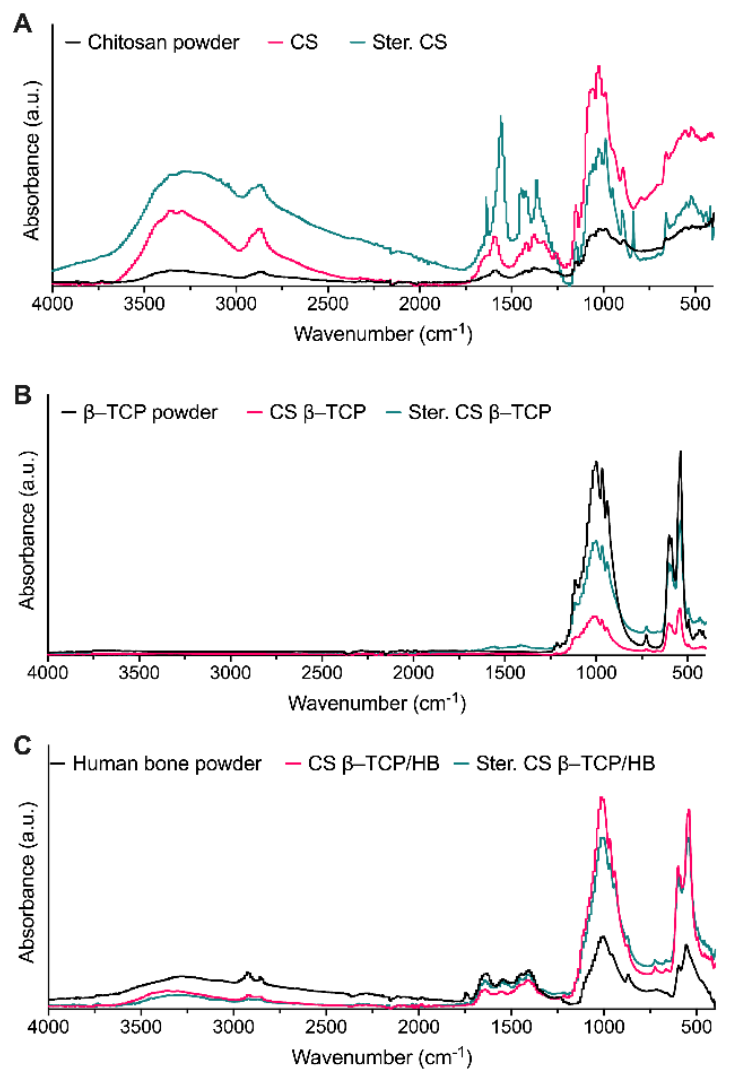
Figure 4. FTIR spectra of starting materials, granulates, and sterilized granulates: ( A )—chitosan-based materials, ( B )—materials with β -TCP only, and ( C )—materials with β -TCP and human bone (HB).